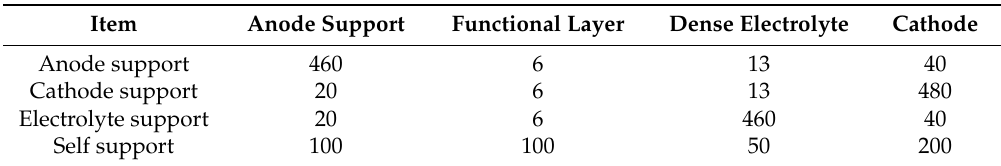
Table 3. Geometry parameters of the anode, cathode, electrolyte and component-self-support button cells in the unit of mm.